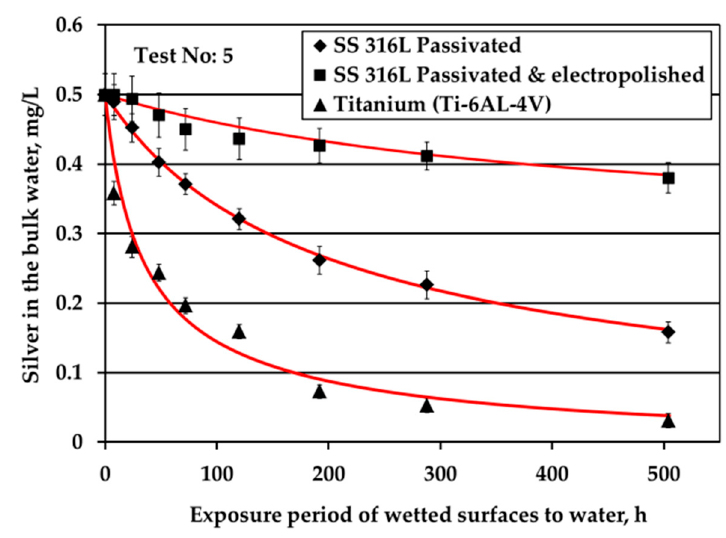
Figure 4. Experimental data of silver loss during tests under water flow conditions along with fitting curves. Table 2. Kinetic constants and maximum uptake capacity for each of the tested